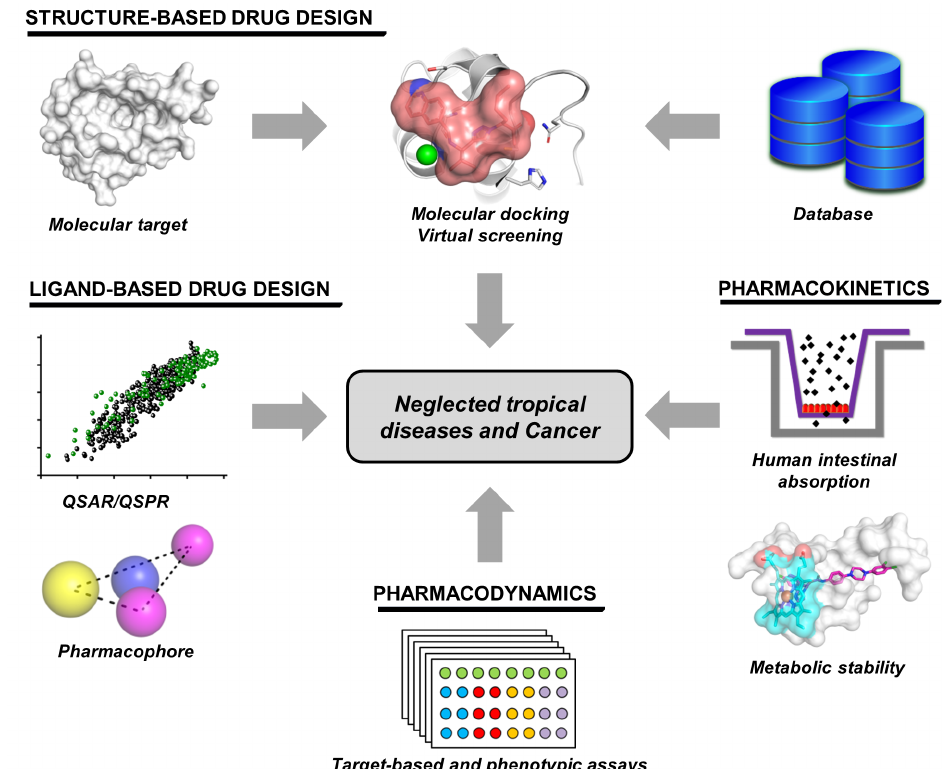
Figure 1 - Drug discovery strategies employed at the Laboratory of Medicinal and Computational Chemistry (LQMC). Ligand- and structure-based drug design methods are used alongside several computational and experimental techniques to evaluate pharmacodynamics and pharmacokinetics in cancer and tropical disease drug